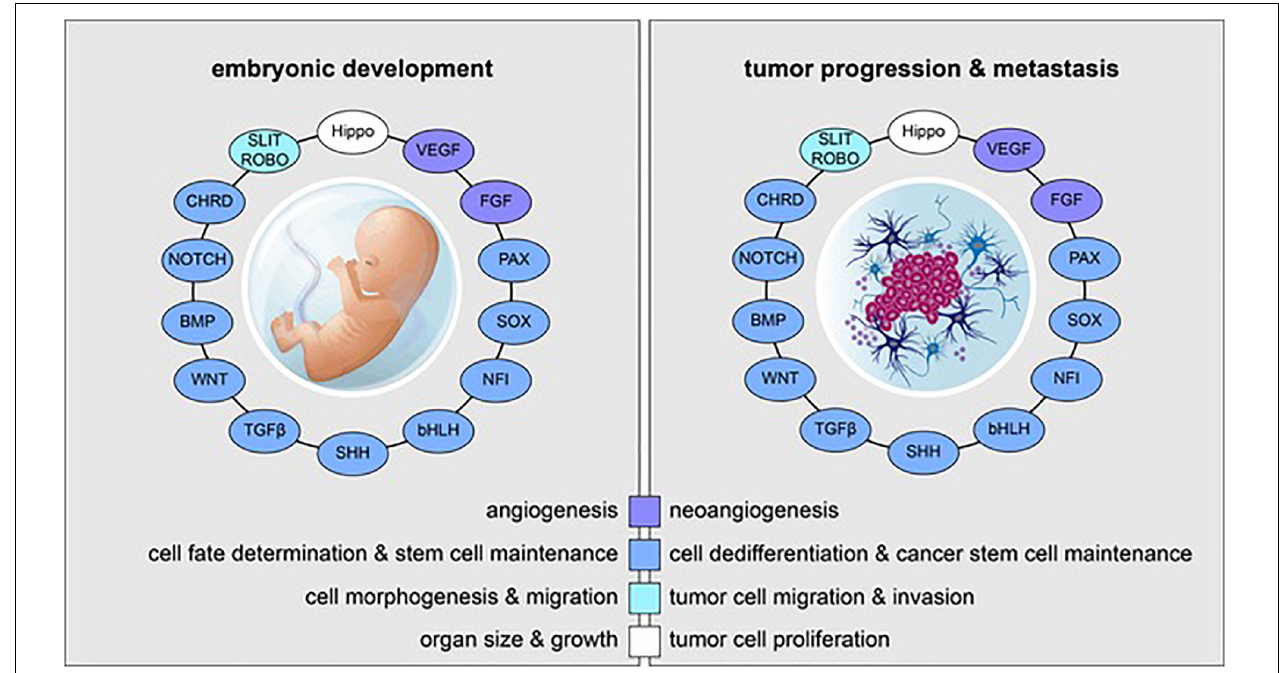
FIGURE 1 | Reactivation of embryonic and developmental signaling pathways in cancer. Examples of embryonic signaling pathways, transcription factor families, and their respective roles in embryonic development (left) and tumor progression and metastasis (right) are shown. Signaling pathways and transcriptional cascades that are essential for proper in utero development are often reactivated in the context of